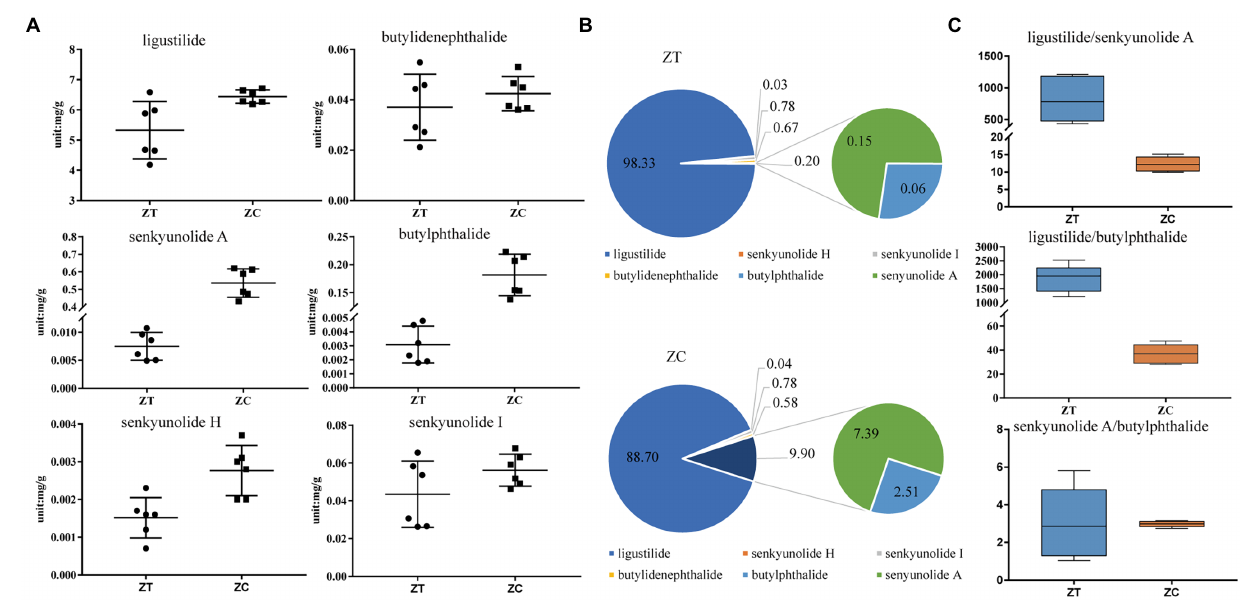
FIGURE 1 | Levels of the tested components across samples. (A) Content levels of the six phthalides in ZT and ZC samples; (B) The percentage of each phthalide level in the total phthalide of ZT and ZC samples; (C) The diagnostic ratios of three characteristic phthalides with large differences, ligustilide/butylphthalide, ligustilide/senkyunolide A, and senkyunolide A/butylphthalide, in ZT and ZC samples.